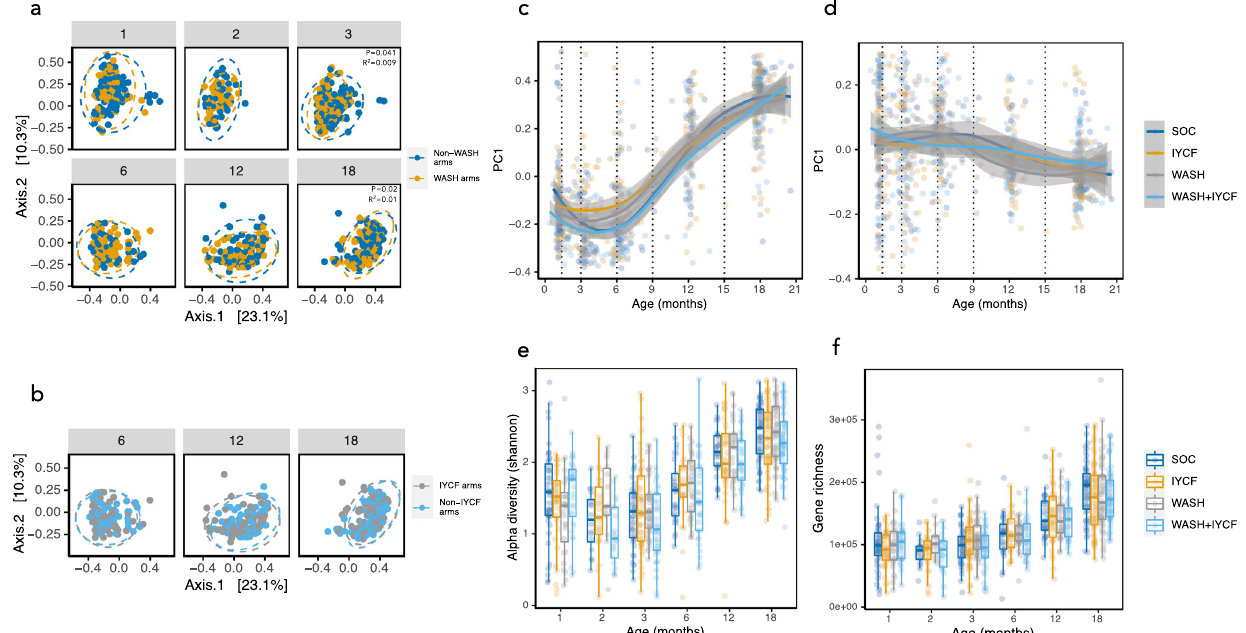
Fig. 2 | Impact of randomized WASH and IYCF interventions on infant gut microbiome. PCoA of Bray-Curtis distances species composition coloured by WASH vs non-WASH arms ( a ), including PERMANOVA model results, and IYCF vs non-IYCF arms ( b ) are plotted (dotted lines represents 95% con fi dence ellipses; two-sidedp-value)inadditiontothe fi rstcomponent(PC1)fromPCoAofspecies( c ) and pathways ( d ; lines represent smoothed conditional means and grey shaded areas represent 95% con fi dence intervals). The IYCF intervention was introduced after 6months of age, therefore direct comparisons of IYCF vs non-IYCF arms are